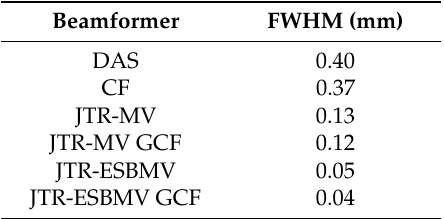
Table 2. FWHM for the simulated point target at z = 30 mm.